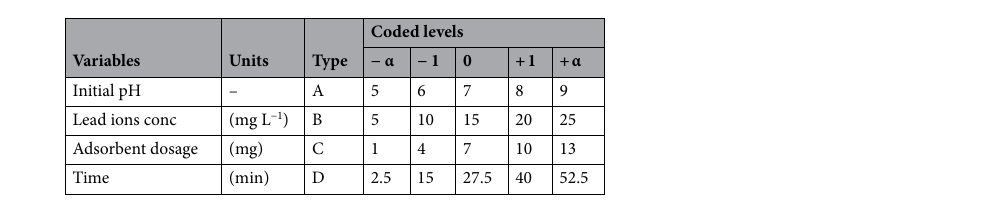
Table 1. Levels of the independent variables for CCD